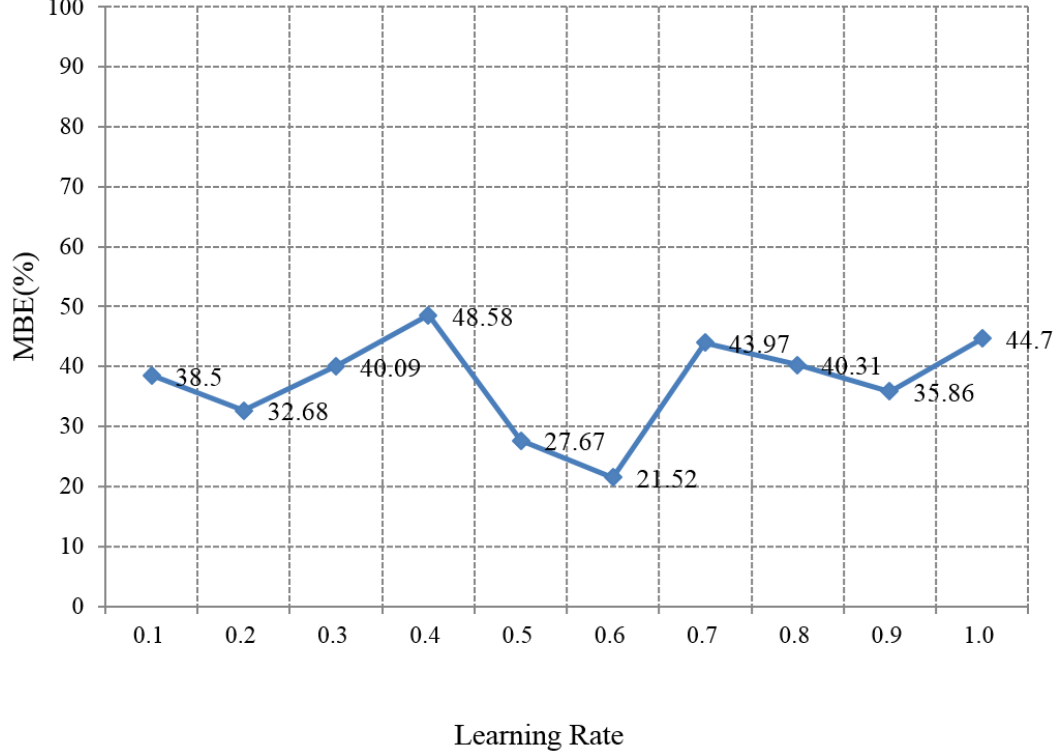
Figure 14. MBE values by learning